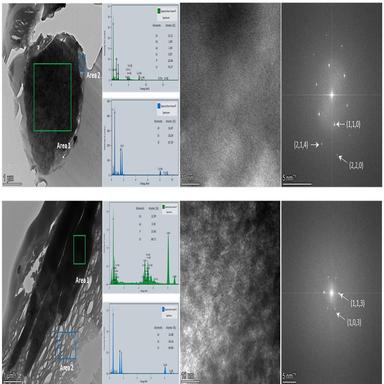
A florencite particle found in the solid residue of SP25-R2.